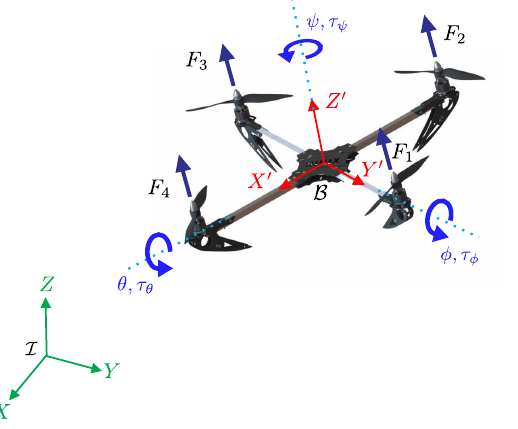
Figure 1. Schematic of a non-linear quadrotor system